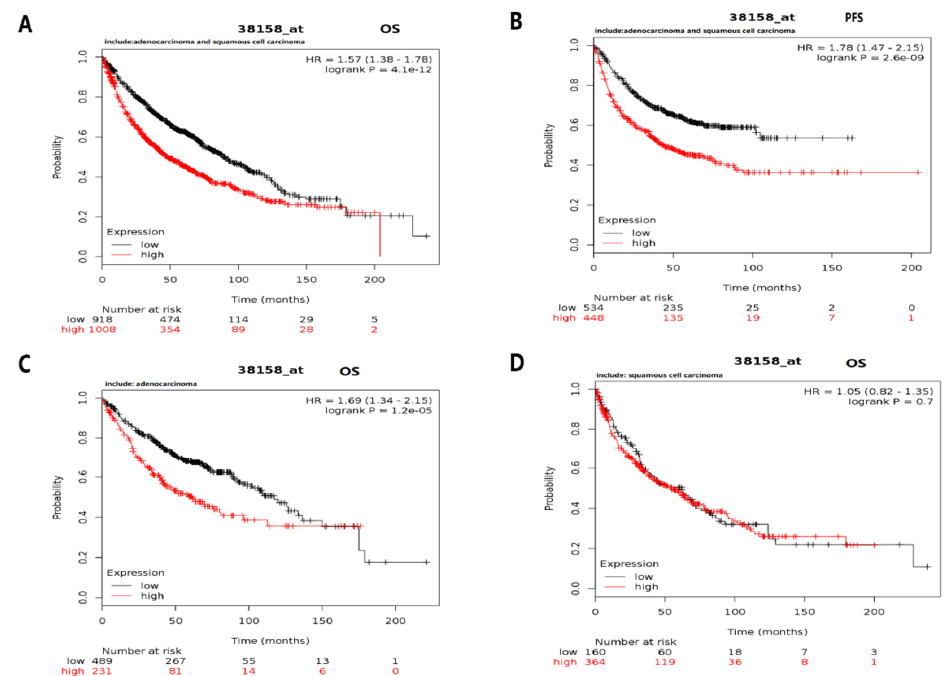
Figure 11. Prognostic potential of ESPL1 in patients with lung cancer determined using Kaplan– Meier plotter. For patients with lung squamous cell carcinoma and lung adenocarcinoma, high expression of the ESPL1 gene was associated with ( A ) poor overall survival and ( C ) poor PFS. mRNA overexpression of ESPL1 was significantly associated with poor OS only in ( B ) patients with lung adenocarcinoma, but ( D ) not in patients with lung squamous cell carcinoma. PFS, progression ‐ free survival; OS, overall survival; HR, hazard ratio (presented with 95% CI); ESPL1, extra spindle pole bodies like 1.